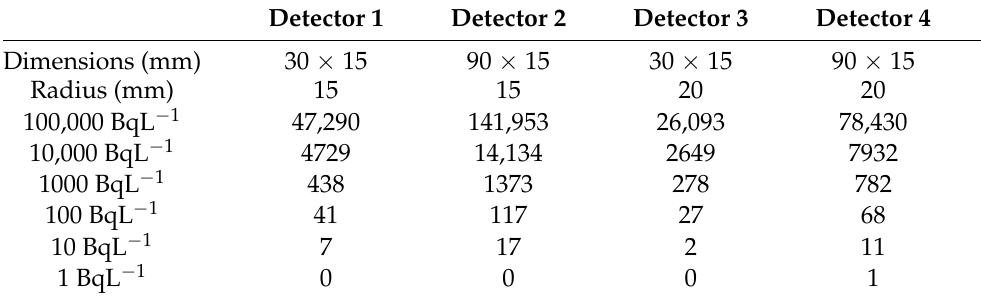
Table 5. The counts observed in a different flexible CdTe sensors deployed in groundwater with varying concentrations of decaying 90 Sr . Each detector had the same material composition but different geometry.